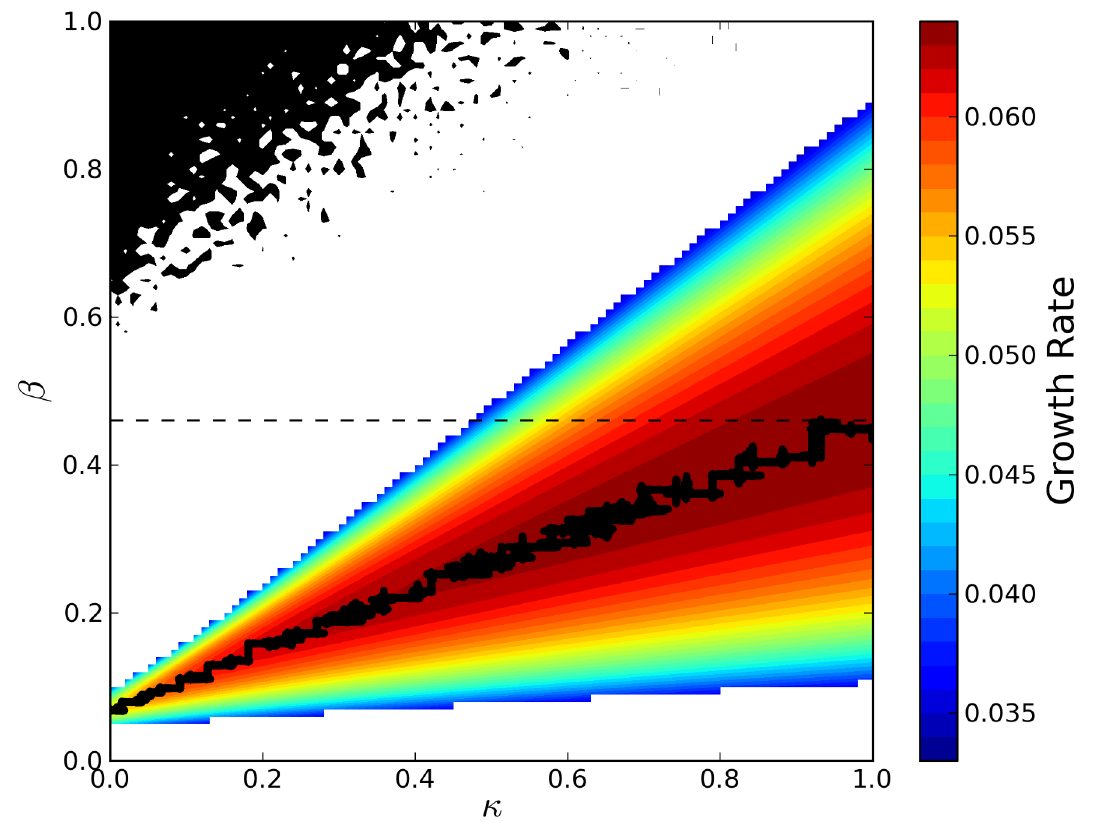
Figure 4. Co-evolution of obedience and baseline replication, in face of constant policing. The heatmap displays the population’s net average growth rate (expressed as the difference between the average division and death rates) as a function of the plasmid replication parameters b and k , averaged across three independent stochastic multicellular simulations with plasmid homogeneity (no mutations) and a fixed rate a ~ 1 of inhibitor production. The white areas below and above the stable region represent the regions of the plasmid parameter space in which plasmids are eliminated from the population due to consistent under- or over- replication respectively. The black clusters in the upper-left corner represent the collapse of the host population under the weight of excessive plasmid replication. The horizontal dashed line indicates the value of b for which the system reaches optimal growth at k ~ 1 (see Figure 5). Finally, the black ladder-like path outlines the evolution of CNC in a stochastic simulation where b and k are allowed to mutate with probability m ~ 10 { 5 and a fixed rate a ~ 1 of inhibitor production.